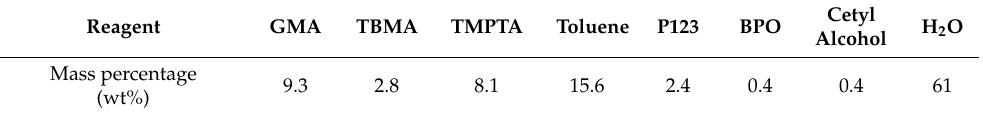
Table 4. The synthesis recipe of porous PA.